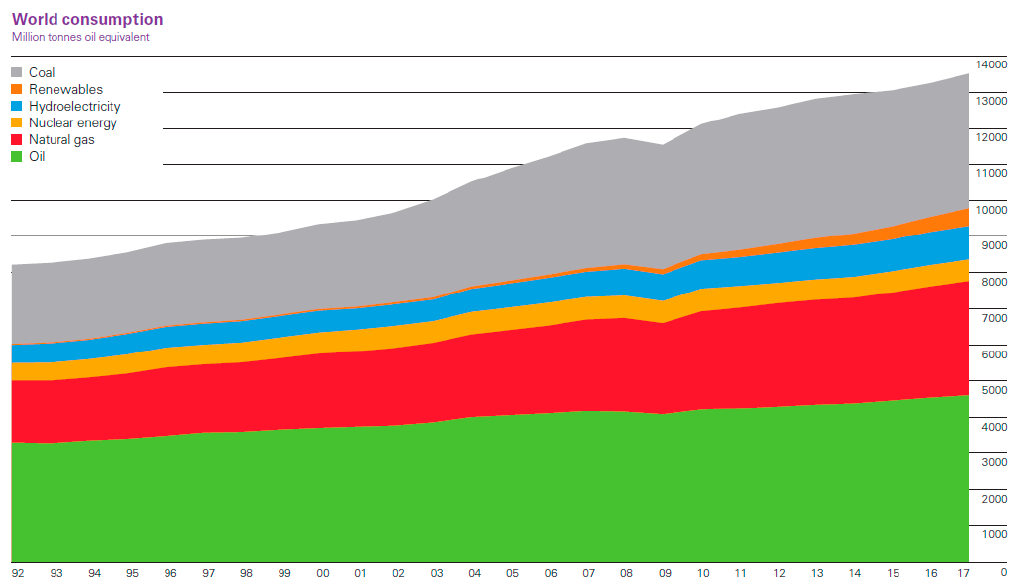
Figure 1. Evolution of world energy consumption by origin during the last 25 years [12].